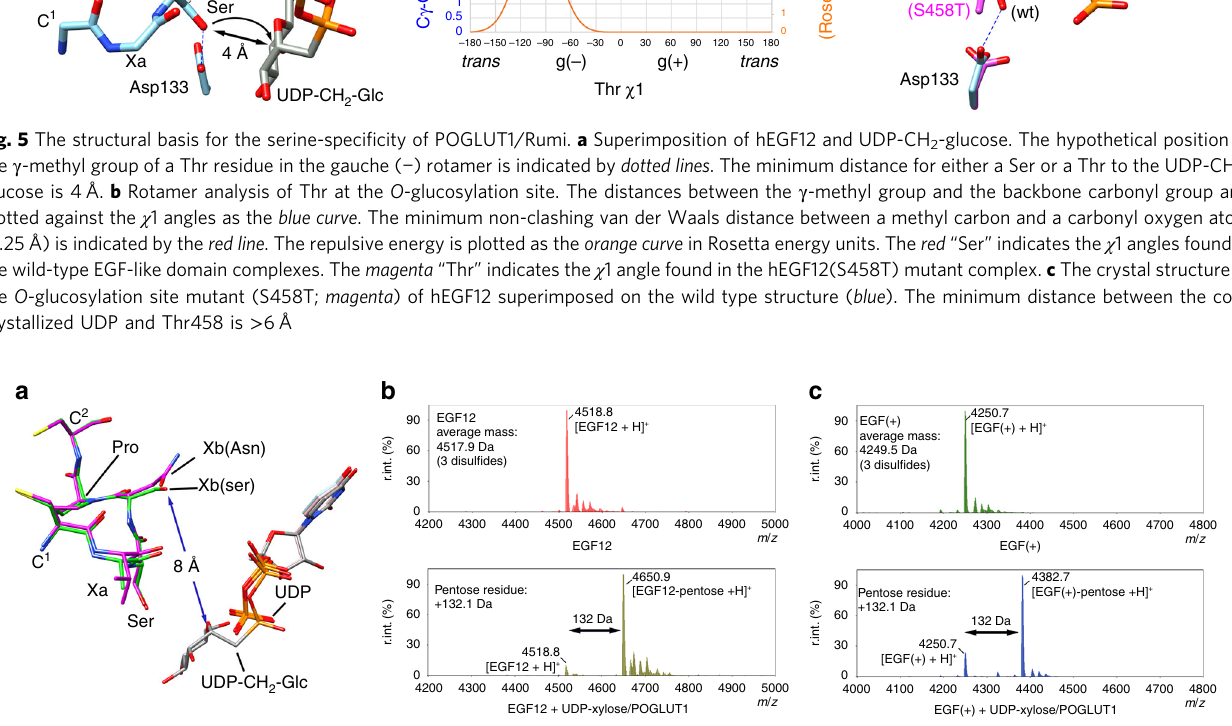
Fig. 6 A diserine-containing motif does not determine the donor substrate speci fi city. a Superimposition of the C 1 XSNPC 2 (hEGF12; magenta ) and C 1 XSSPC 2 (hF7EGF1; green ) motifs and the UDP-CH 2 -glucose complex. The Xb residue that de fi nes a diserine-containing motif is 8 Å away from